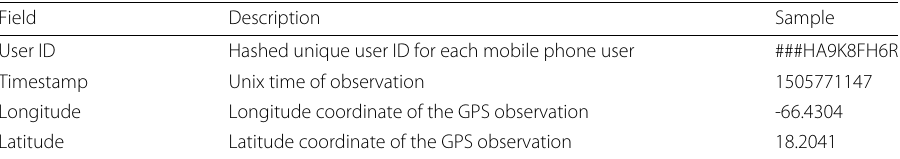
Table 1 Fields and content of mobile phone location